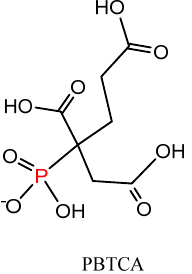
Figure 1. The chemical structure of PBTCA.